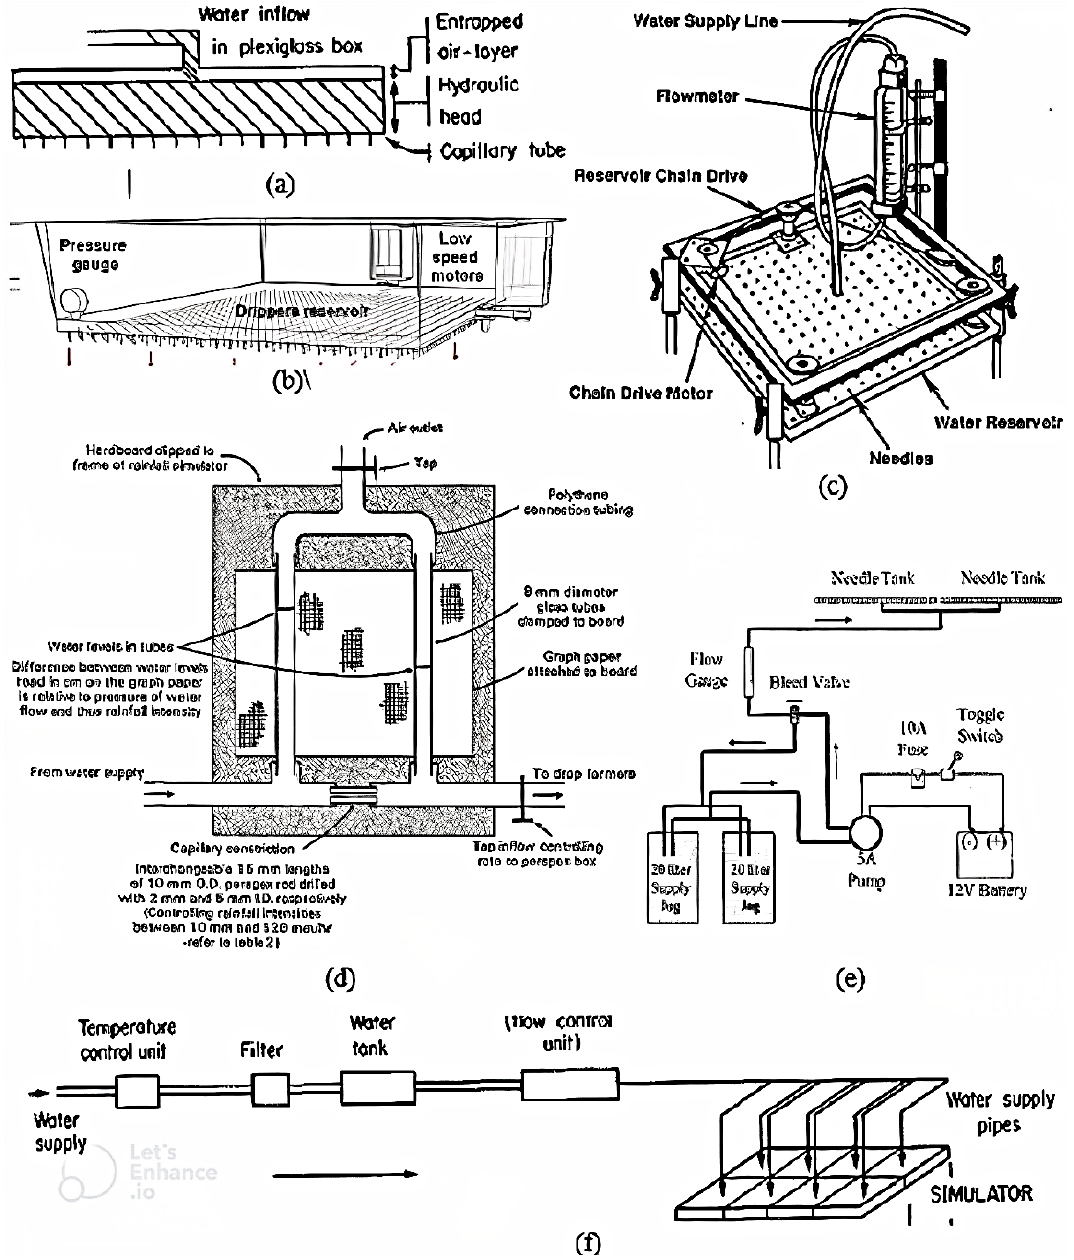
Figure 4. Different mechanisms of simulator operation: ( a ) Air and water medium inside the water tank with drippers [1] (Reprinted/adapted with permission from Ref. [Riezebos & Seyhan, 1977]); ( b ) Low speed motors rotating mechanism of drippers reservoir with pressure gauge [58] (Reprinted/adapted with permission from Ref. [Wang et al., 2018]); ( c ) DRS >1 with flow meter and water tank with drippers rotation mechanism [87] (Reprinted/adapted with permission from Ref. [Guerrant et al., 1990 ]); ( d ) Water pressure gauge with control valves [8] (Reprinted/adapted with permission from Ref. [Bowyer & Burt, 1989]); ( e , f ) Schematic representation of the order of DRS >1 elements [1,19] (Reprinted/adapted with permission from Ref. [Riezebos & Seyhan, 1977; Battany & Grismer, 2000]).